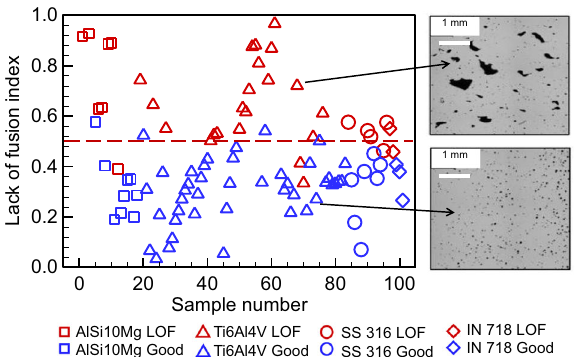
Fig. 5 Lack of fusion index from linear regression. Distribution of lack of fusion susceptibility index for 101 experimental cases. The dashed line at the index = 0.5 delineates the ‘ LOF ’ and ‘ Good ’ cases. Here, ‘ LOF ’ represents cases with defects and the cases where no defects were observed are indicated by ‘ Good ’ . The results are also tested using independent experimental data on the lack of fusion during PBF-L of AlSi10Mg alloy 10 . The two microstructures are adapted from ref. 10